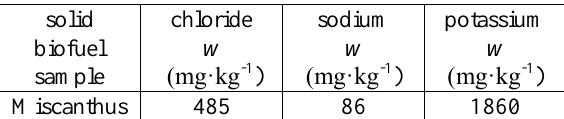
Figure 7. Ion chromatographic analysis of Miscanthus aqueous solution, cation separation Table 2. Chloride, sodium and potassium concentrations, w (mg·kg -1